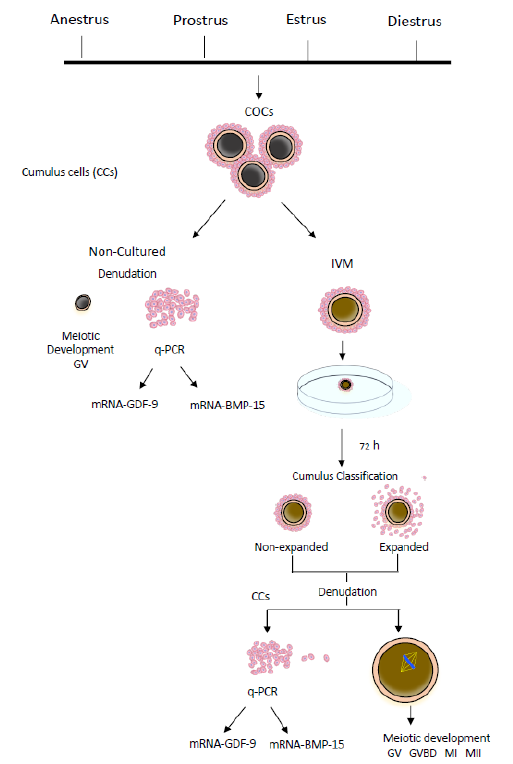
Figure 1. Experimental design. CCs: cumulus cells; COCs: cumulus–oocyte complexes; IVM: in vitro maturation; q-PCR: quantitative real-time polymerase chain reaction; GV: germinal vesicle; GVBD: resumption of meiosis or germinal vesicle breakdown; MI: first metaphase; MII: second metaphase.